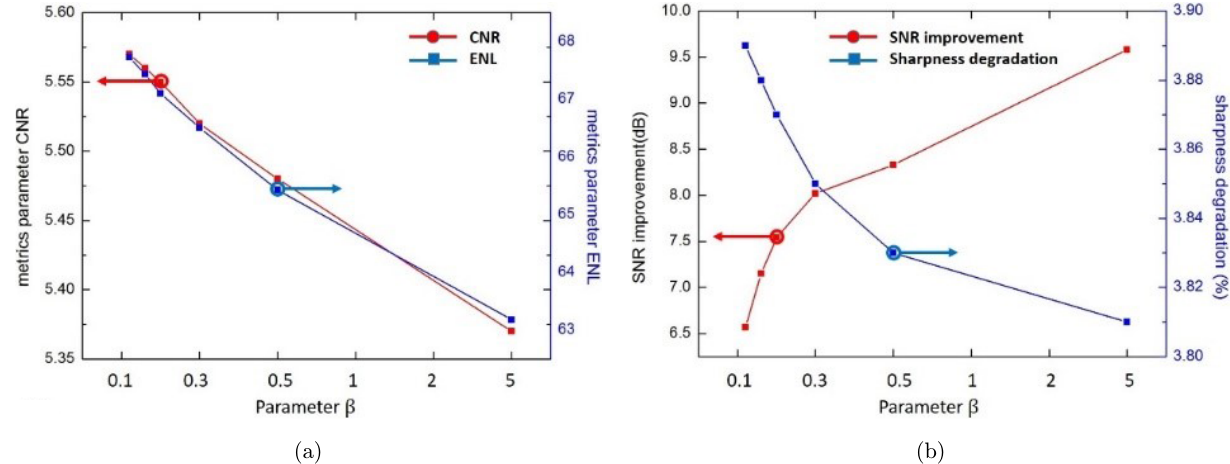
Fig. 5. Diagram of four metrics vs parameter (cid:2) (when (cid:1) ¼ 0 : 2, K ¼ 1 : 2). (a) Calculated CNR and ENL decrease when (cid:2) varies from 0.1 to 5.0. (b) Calculated SNR and XCOR increase when (cid:2) varies from 0.0 to